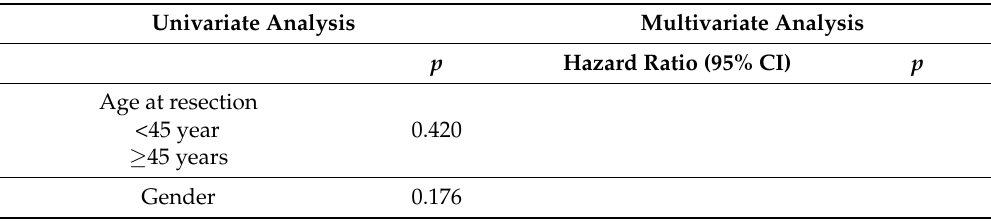
Table 4. Independent predictions of early recurrence after curative HCC resection in patients with pathologically confirmed liver cirrhosis under antiviral therapy.